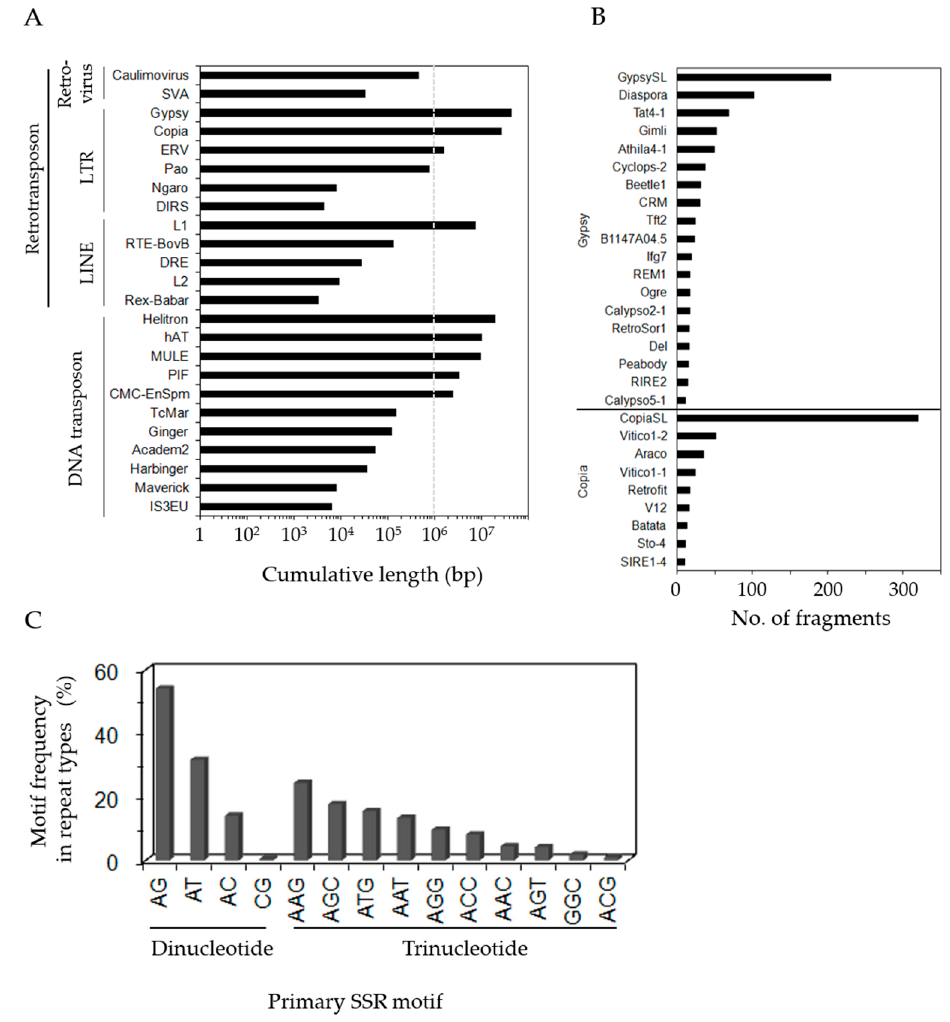
Figure 3. The abundance of repeat sequences in unigenes. ( A ) The distribution of transposable element (TE) sequences in the unigenes. Identified TE sequences were classified into class I (retrotransposons) and class II (DNA transposons) elements with more detailed families. ( B ) The distribution of Ty3/gypsy - and Ty1/copia -encoding sequences annotated from Gydb. ( C ) Frequency of simple sequence repeat (SSR) motifs discovered in the unigenes from P. ginseng based on representing various repeat-motif types. LTR: long terminal repeat; LINE: long interspersed nuclear element.